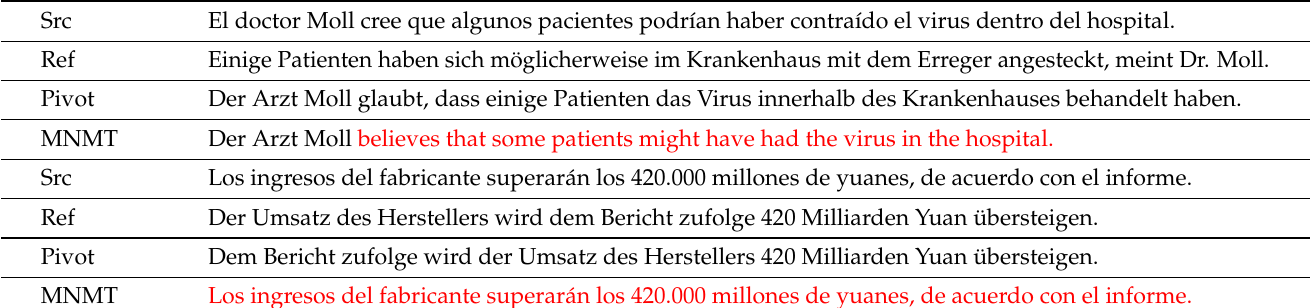
Table 1. Comparison between zero-shot translation with a baseline MNMT model and a pivot-based translation (English as the pivot language) for Spanish → German. The baseline MNMT model often translates into an incorrect language, such as translating into English rather than German or copying the source